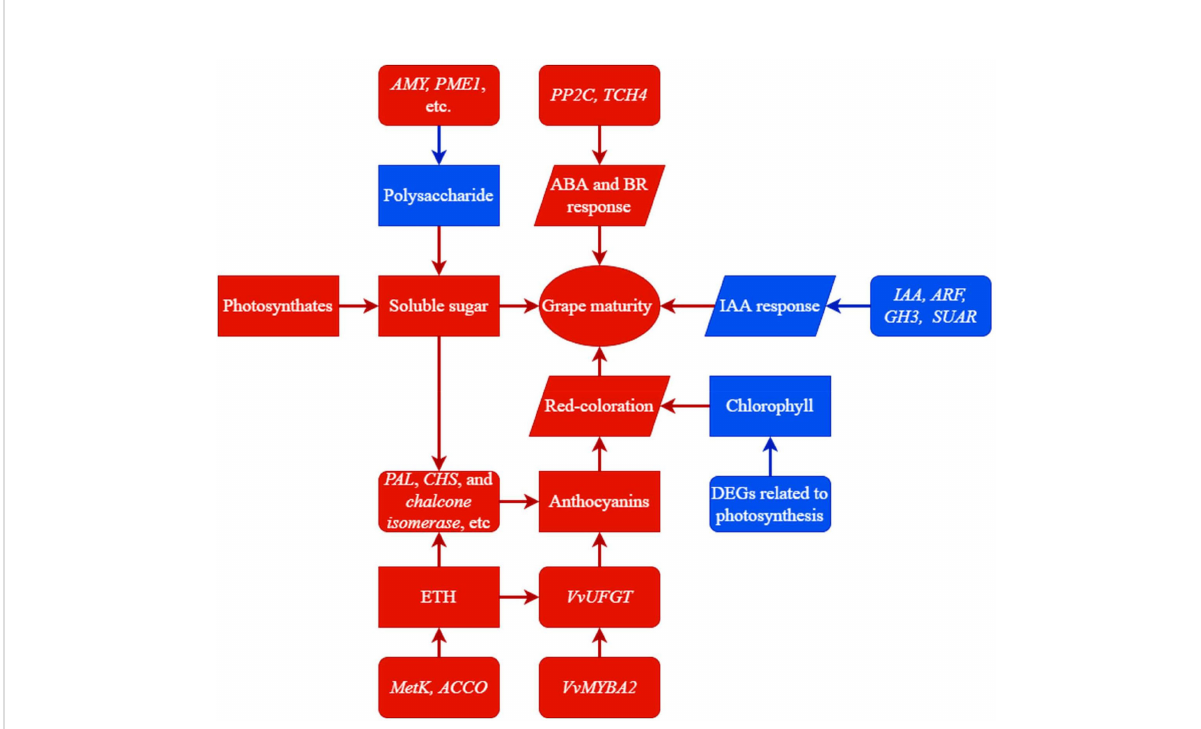
FIGURE 9 A summary of trunk girdling effects on berry development promotion. Rectangles represent contents of substances. Parallelograms represent activities of biological processes. Rounded rectangles represent expressions of genes. Red color in directional connectors represents a positive effect on terminal side; otherwise, it represents an increase in expression, content, or activity. Blue color in directional connectors represents a negative effect on terminal side; otherwise, it represents a decrease in expression, content, or